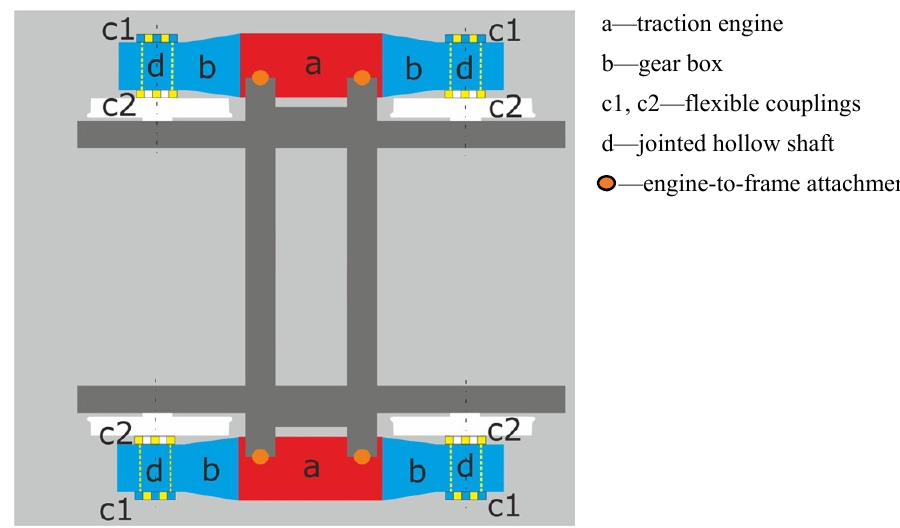
Figure 5. Drive system with two motors, where one motor drives two left or right wheels, source: